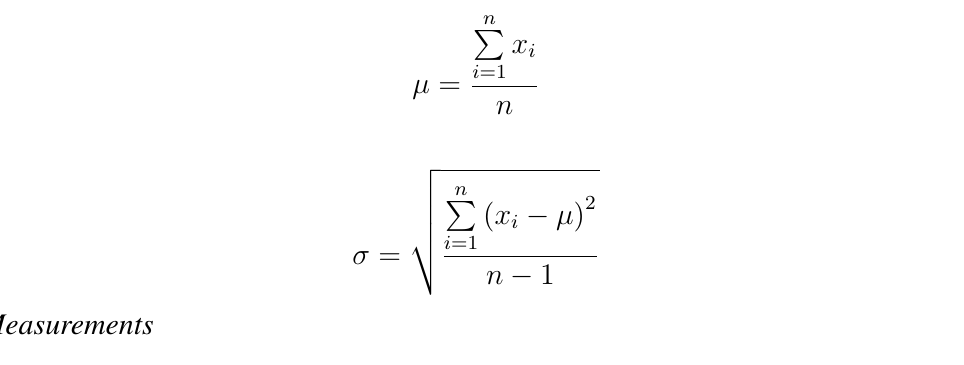
Figure 6. Antenna orientation for measurement of the packet loss rate of IPANEMA generation 2 nodes. The double-headed arrows represent the master antenna and the single-headed arrows represent the slave antenna. Black arrows represent antennas on the top of the circuit board, and grey arrows the antennas on the bottom of the circuit board.